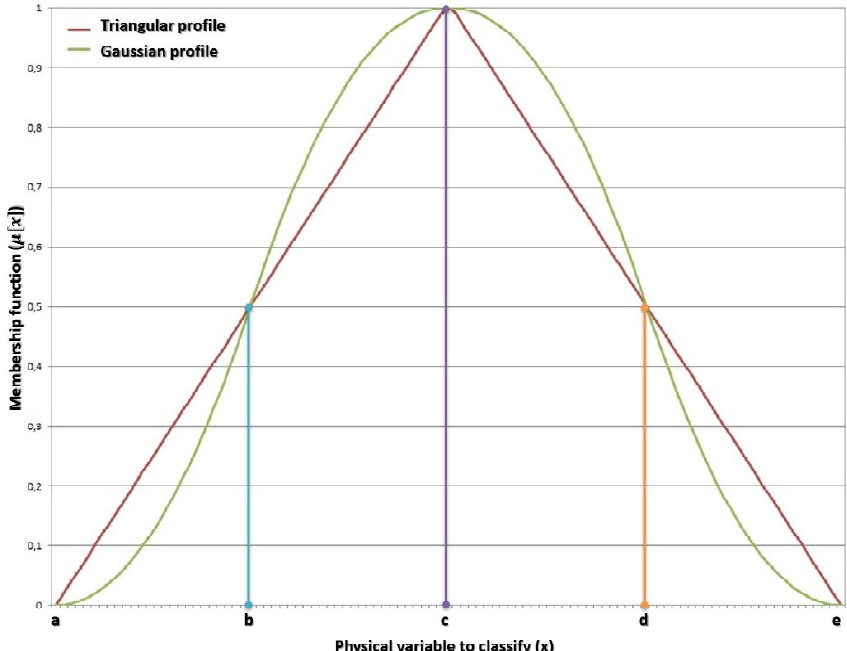
Fig. 2. Graphical representation of the Gaussian and triangular functions to variable fuzzy value belonging.